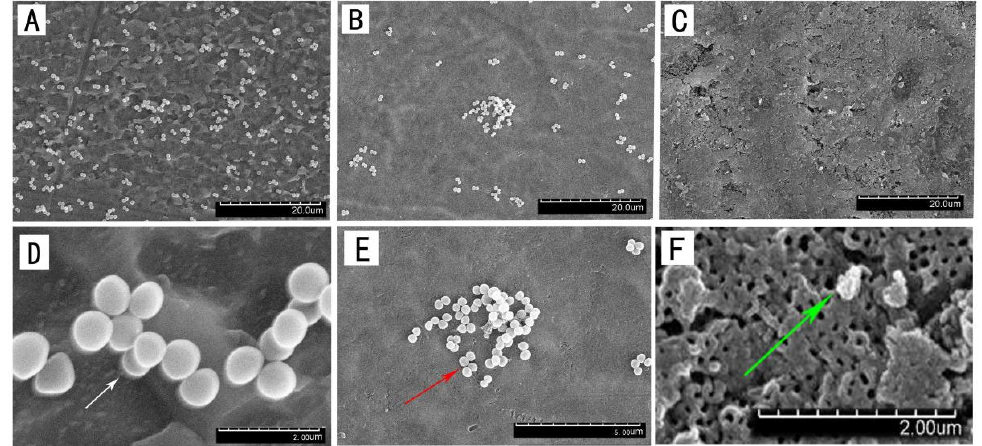
Figure 6. Figure ( A – E ) Antibacterial efficacy in vitro. SEM pictures of colonies of bacteria after 6 h on ( A ) Ti, ( B ) TNT, and ( C ) HA/gentamicin/TNT. The bacteria exhibited a typical morphology on ( D ) Cp–Ti (white arrow) and ( E ) TNT (red arrow). However, the morphology of bacteria was compromised when grown on the ( F ) gentamicin ‐ loaded NTs (green arrow).